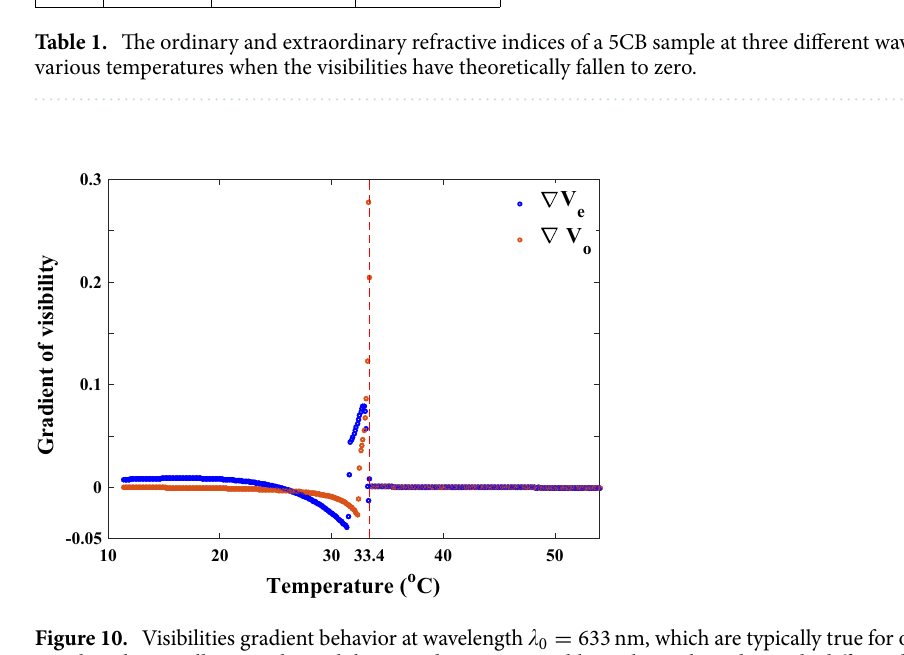
Figure 10. Visibilities gradient behavior at wavelength (cid:31) 0 = 633 nm, which are typically true for other wavelengths as well. Using the visibilities gradient, it is possible to obtain three distinctly different behaviors with temperature: nonlinear in the nematic phase, zero value in the isotropic phase, and rapid and significant variations around T C , which indicate the singularity in this temperature. The visibility gradient diagrams will lead to the same conclusions, which we may infer from Figs. 5 and 6, clearly